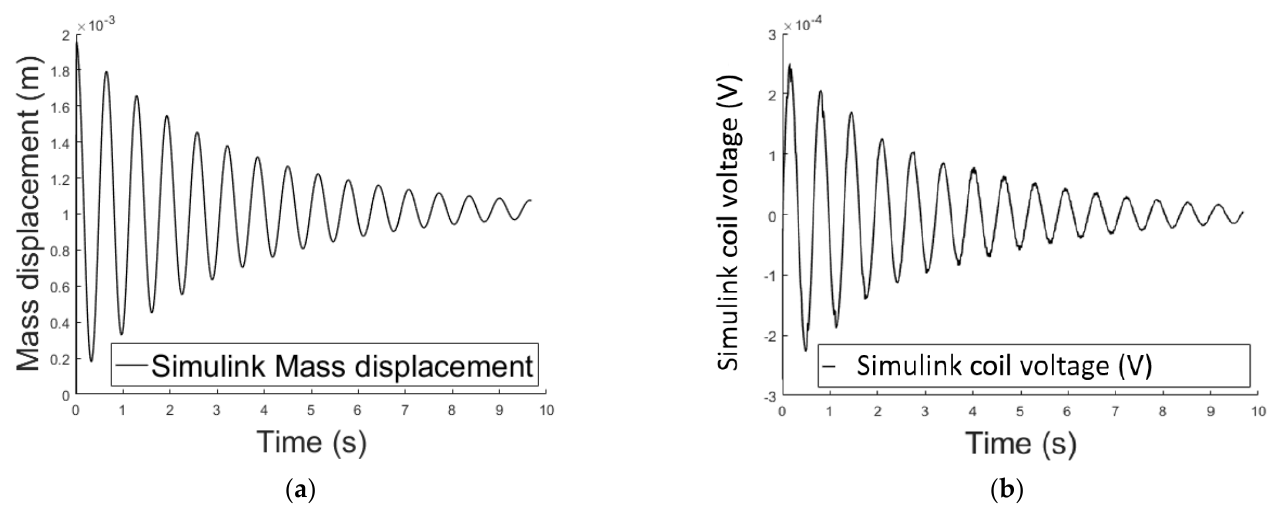
Figure 6. ( a ) Air gap length variation over time using the analytical Simulink implementation; ( b ) variable voltage across the electromagnet’s coil over time using the analytical Simulink implementation.